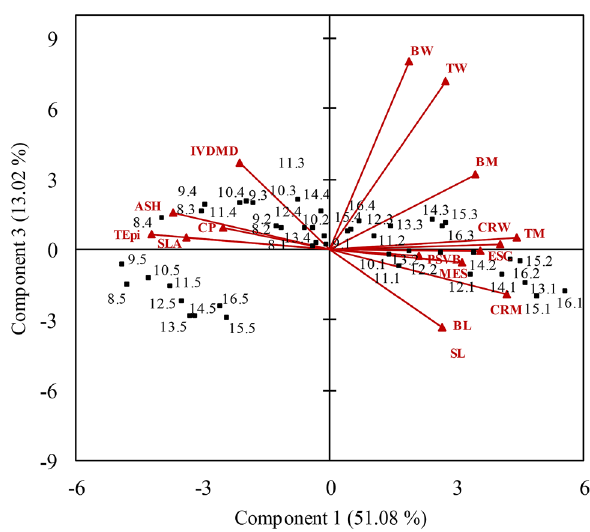
Figure 6. Biplot PC1 × PC3 for morphological (blade length (BL), segment length (SL), total width (TW), blade width (BW), central rib width (CRW), total mass (TM), blade mass (BM), central rib mass (CRM) and specific leaf area (SLA)), anatomical (sclerenchyma (SCL), parenchymatic sheath of vascular bundles + vascular tissue (PSVB), mesophyll (MES) and total epidermis (TEpi)) and nutritive value (crude protein (CP), in vitro dry matter digestibility (IVDMD) and ash (ASH)) characteristics of leaves with contrasting levels of insertion on the tiller axis (phytomers) of Napier elephant grass. Points represent the phytomers with their respective segments and arrows represent the vector for each